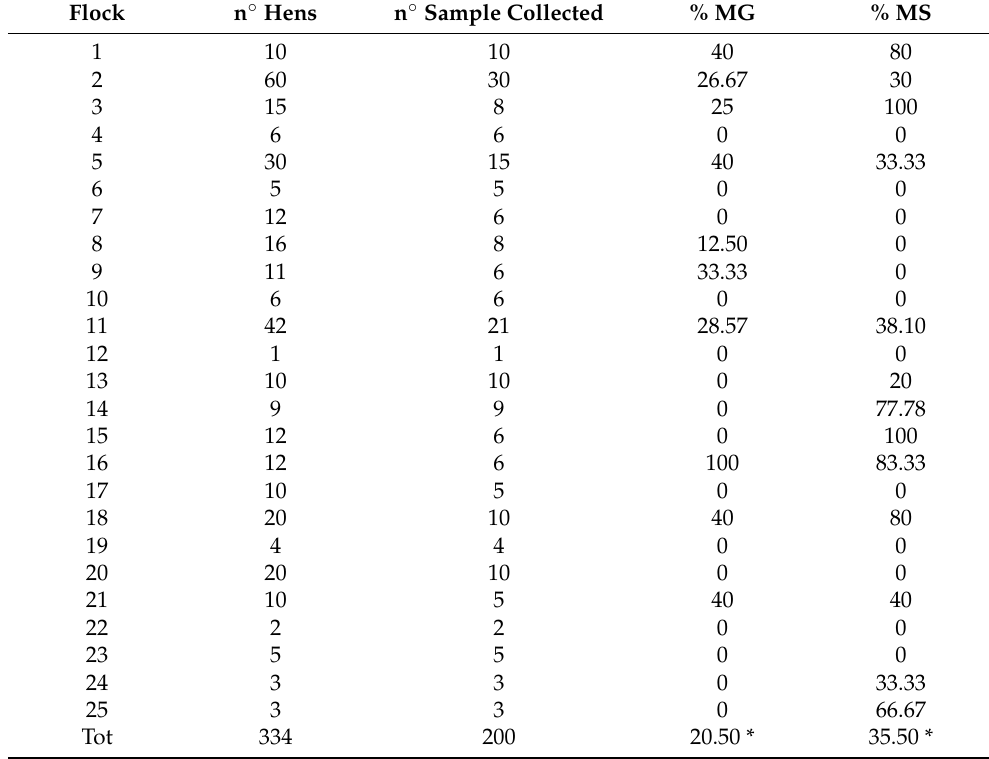
Table 1. Prevalence of MG and MG in rural flocks (* average prevalence).